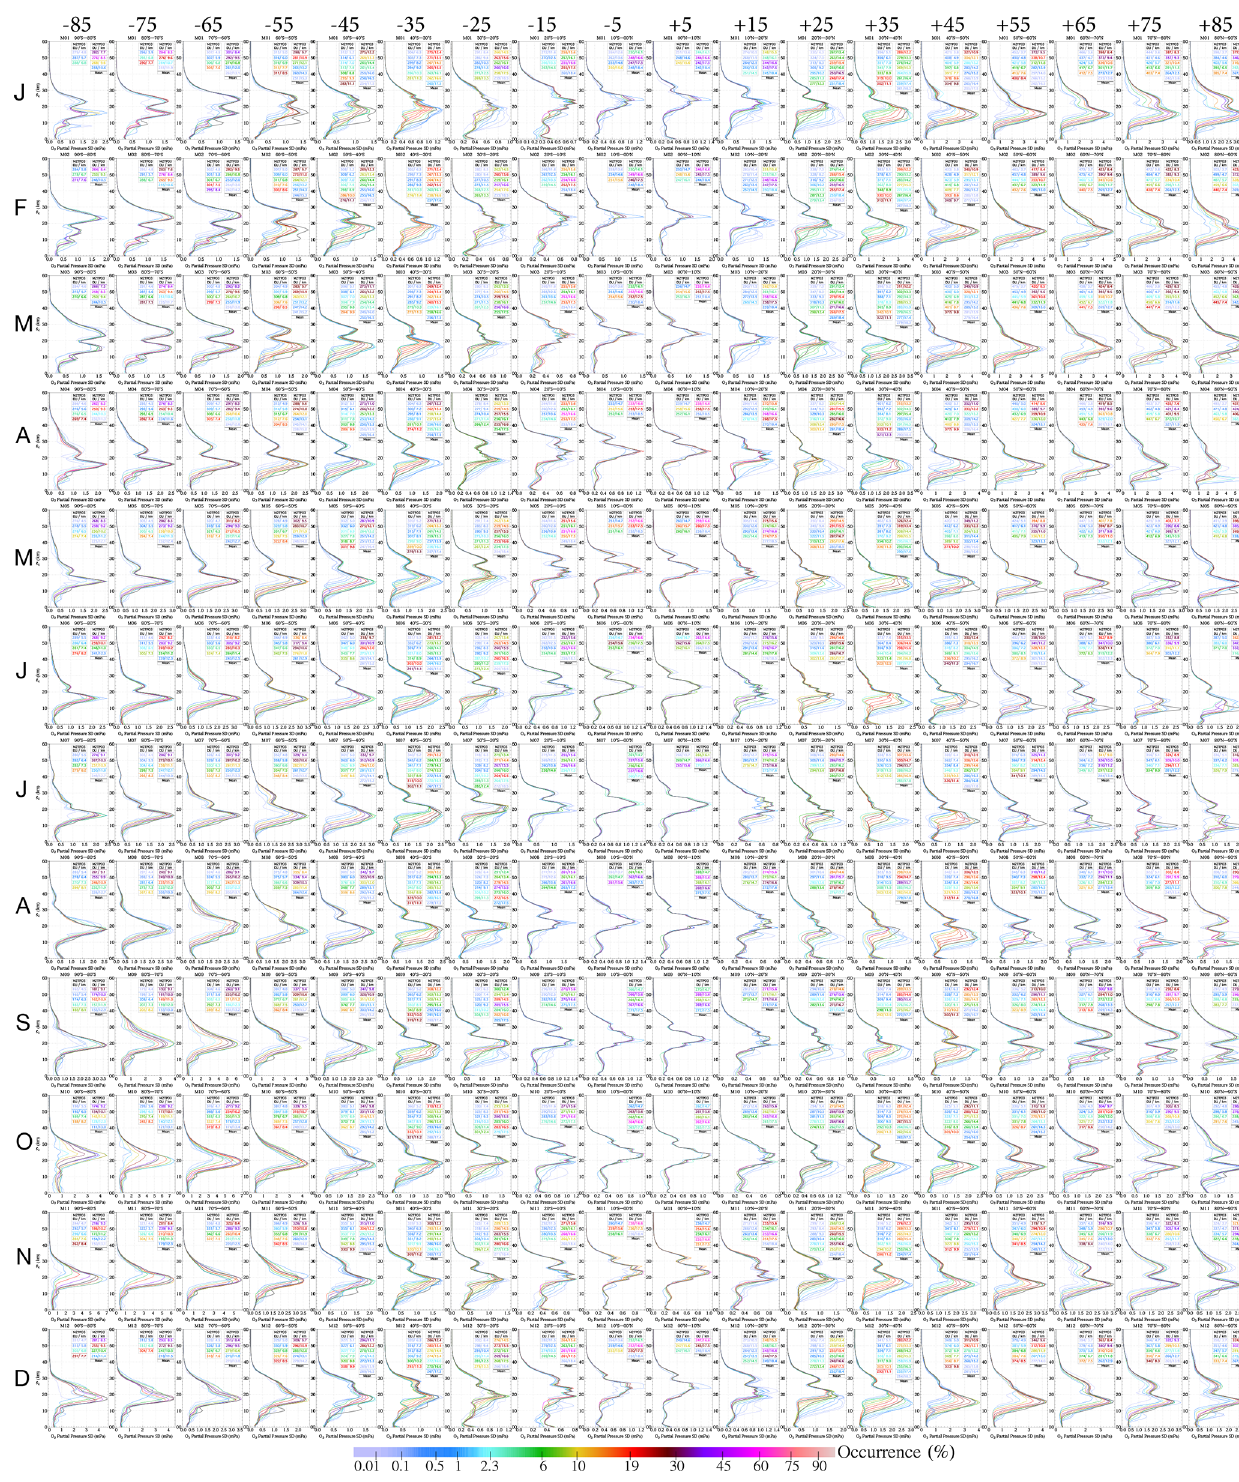
Figure A2. Similar to Fig. A1, except for profile standard deviations in daytime M2TPO3 climatology. This illustrates that tropopause pressure classification in general reduces the variability of the climatological